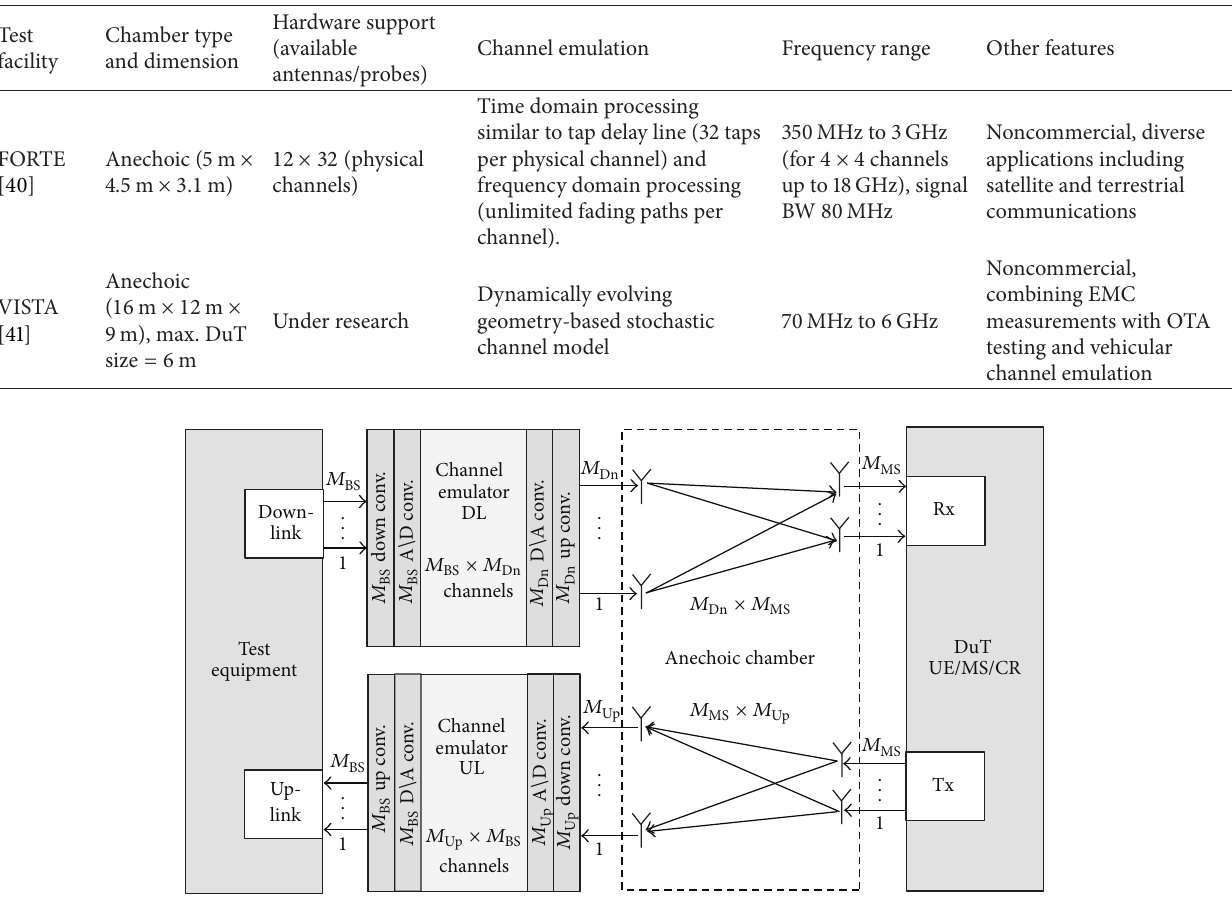
Figure 6: Schematic diagram of a closed-loop OTA setup (OTA in VEE) with full emulation of spatiotemporal channels in uplink (UL) and downlink